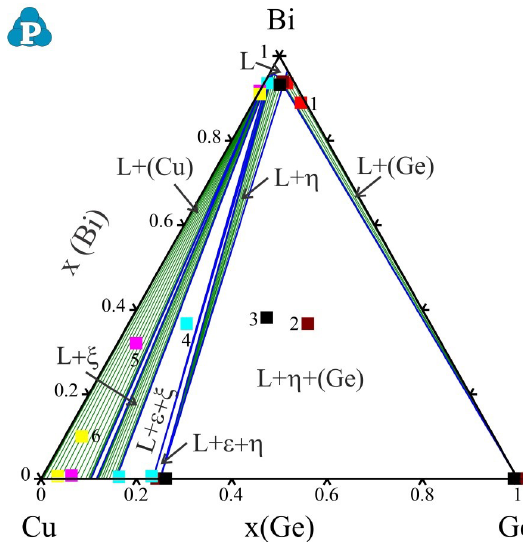
Figure 5. Calculated Bi-Cu-Ge isothermal section at 600 °C compared with EDS results given in Table 2